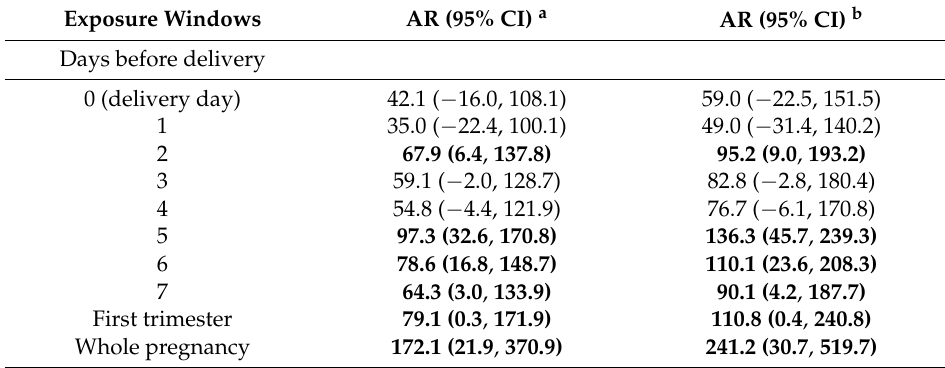
Table 3. Annual excess number of stillbirths (per 100,000 births per year) associated with exposures to